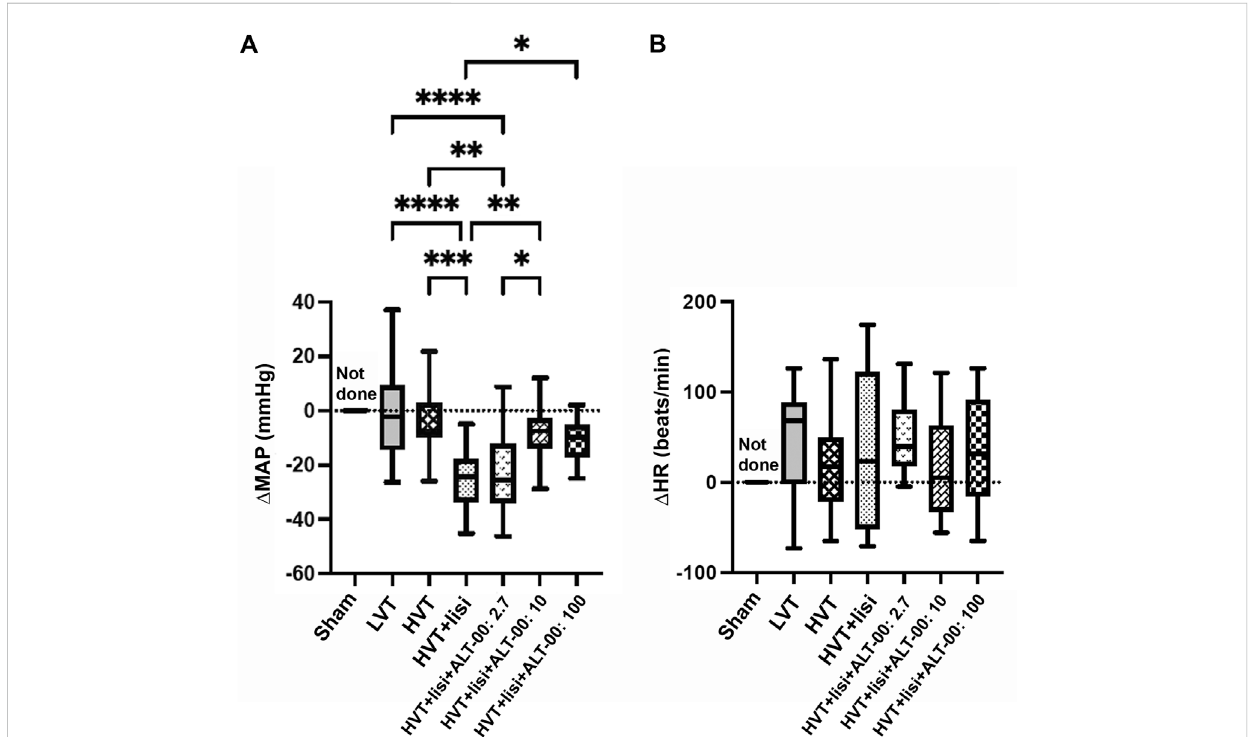
FIGURE 1 Hemodynamic parameters after 4 h of ventilation. (A) Mean arterial pressure (MAP): High tidal volume (HVT) ventilation + lisinopril (lisi) infusion substantially decreased the MAP shown here as a negative Δ MAP (=MAP at 4 h – MAP at baseline), which was prevented by additional treatment with ALT-00 at 10 and 100 μ g/kg/min. With an ALT-00 dose of 2.7 μ g/kg/min, the MAP did not change versus HVT + lisi and remained decreased versus the untreated HVT and LVT groups and the HVT group + lisi + ALT-00 at 10 μ g/kg/min. (B) Heart rate (HR): Δ HR (= HR at 4 h – HR at baseline) showednostatisticaldifferencesbetweenthegroups, n =14/group,hemodynamicmeasurementsafter 4 hnotdoneintheshamgroup, **** p < 0.0001, *** p < 0.001, ** p < 0.01, * p < 0.05, compared by one-way analysis of variance with Tukey posttest.